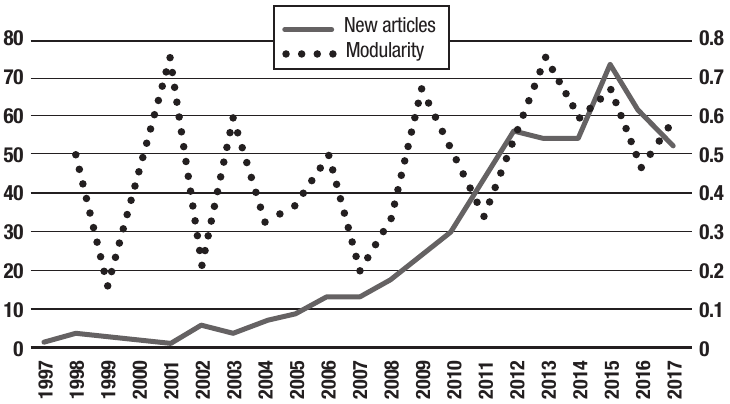
Figure 3. Structural changes in the network measured